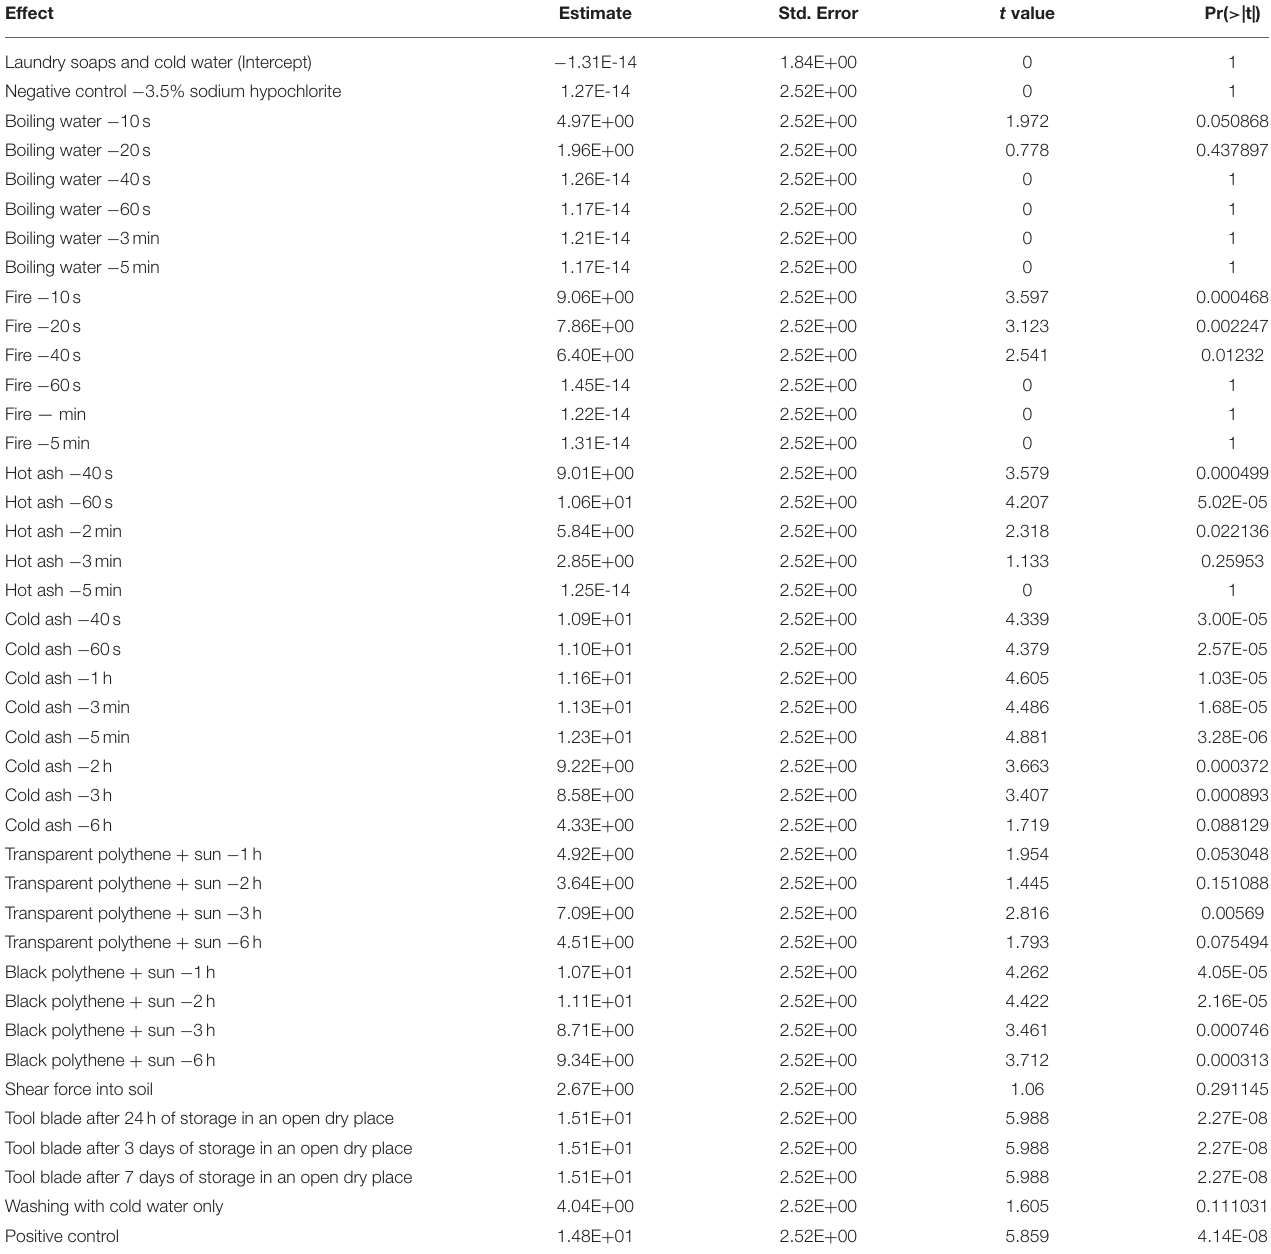
TABLE 3 | Fixed effects of different methods of tool sterilization on the colony forming units of Xanthomonas vasicola pv. musacearum ( Xvm ) per mL of a suspension obtained from the surface of Xvm -contaminated farm